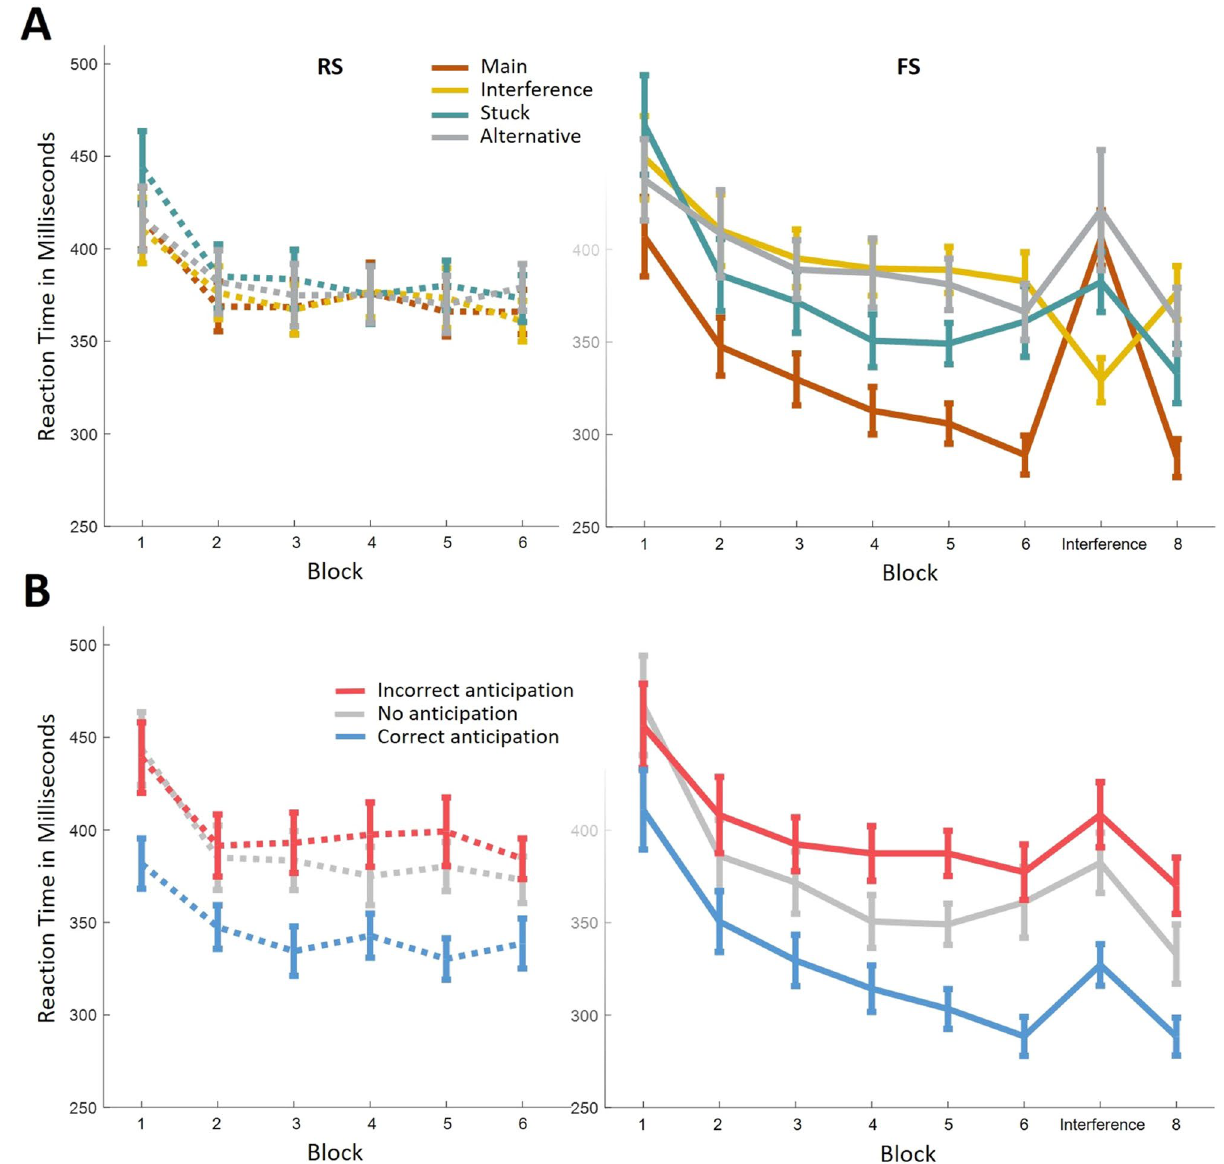
Figure 4. RT according to the oculomotor anticipation preceding it. ( A ) RT in all trials improve with learning. RT of the RS group is similar across all types of anticipation preceding the trial (Left panel). RT of the FS group shows distinct modulation by anticipation type. Namely, RT following Main anticipations have the steepest improvement curve. During the learning phase (blocks 1 to 6) RT following Main anticipations (correct anticipations) is quickest, RT following interference or Alternative anticipations (incorrect anticipations) is the slowest and RT following Stuck anticipations (no anticipation attempt) is in between. ( B ) Data of ( A ) is depicted according to the correctness of the anticipation attempt preceding the trial. In the RS group, correct anticipation yields quicker response, as would be expected. This difference was not evident in ( A ) because Main and Interference anticipations are both a mix of correct and incorrect anticipations. In the FS group, it should be noticed that during sequence interference (block seven) Main anticipations are incorrect and Interference anticipations are the new correct anticipation. This portrayal of the data from ( A ) demonstrates that sequence interference has a similar effect on all trials, regardless of anticipation correctness. Error bars denote standard error of the